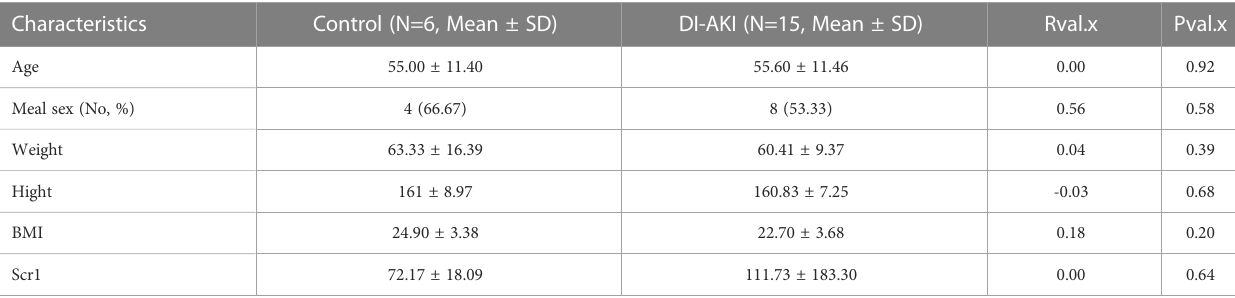
TABLE 4 Basic information and single factor analysis between DI-AKI group and Non-DI-AKI group.